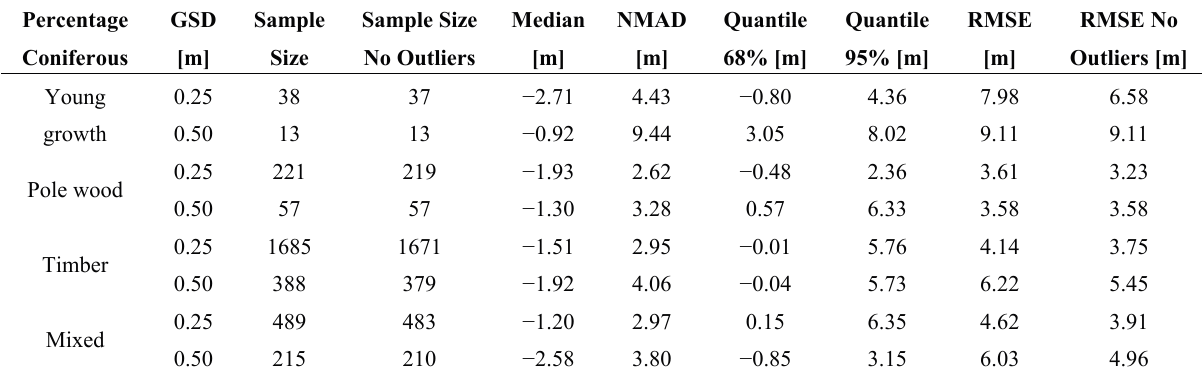
Table A8. Agreement of canopy height calculated from the CHM with the terrestrially measured canopy height according to stages of stand development. A threshold value of ±3 × RMSE was applied for outlier exclusion.